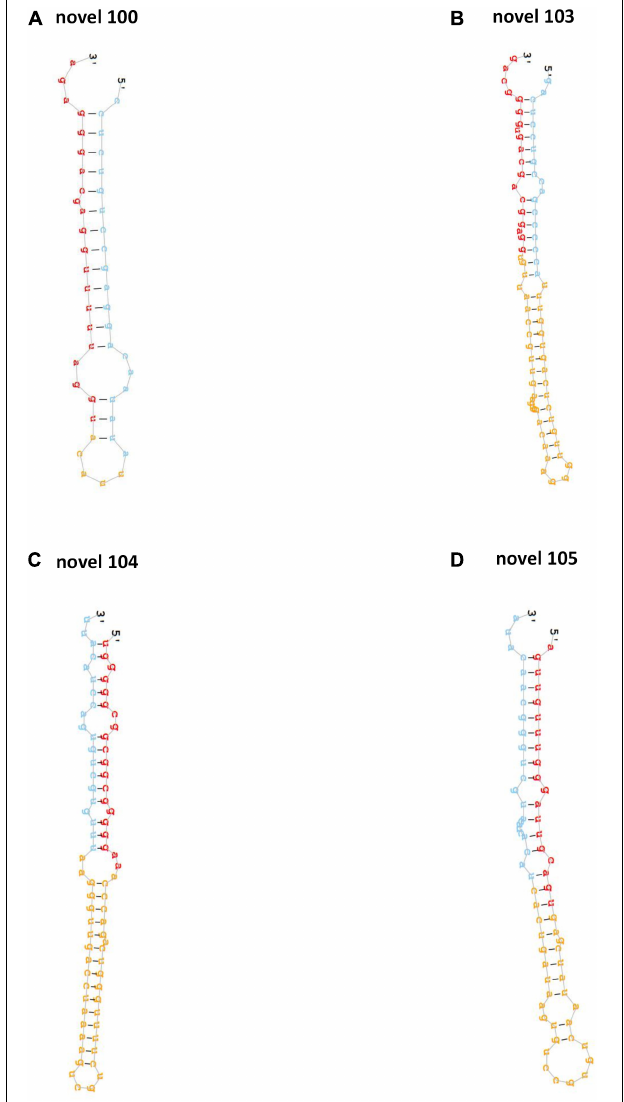
FIGURE 1 | The hairpin structures of four novel precursor miRNAs. The secondary structures of four novel precursor miRNA identified in this study, including novel-100 (A) , novel-103 (B) , novel-104 (C) and novel-105 (D) .